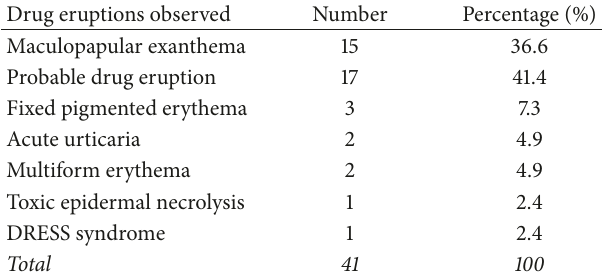
Table 1: Different drug eruptions